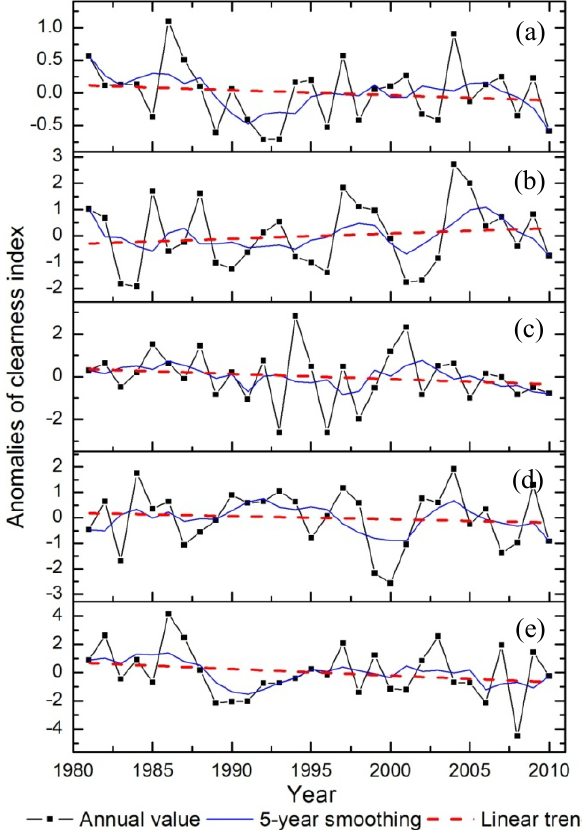
Fig. 9. Anomalies of annual and seasonal clearness index averaged all across China from 1981 to 2010 ( a denotes annual clearness in- dex; b , c , d and e denote seasonal clearness index of spring, sum- Figure 9. Anomalies of annual and seasonal clearness index averaged all over China from 3 mer, autumn and winter, respectively. Unit: %). The averages are 48.47, 48.52, 46.48, 50.92 and 49.43, 1981 to 2010 ( a denotes annual clearness index; b , c , d and e denote seasonal clearness index 4 of spring, summer, autumn and winter respectively. Unit: %). The averages are 48.47, 48.52, 5 46.48, 50.92 and 49.43 respectively. 6